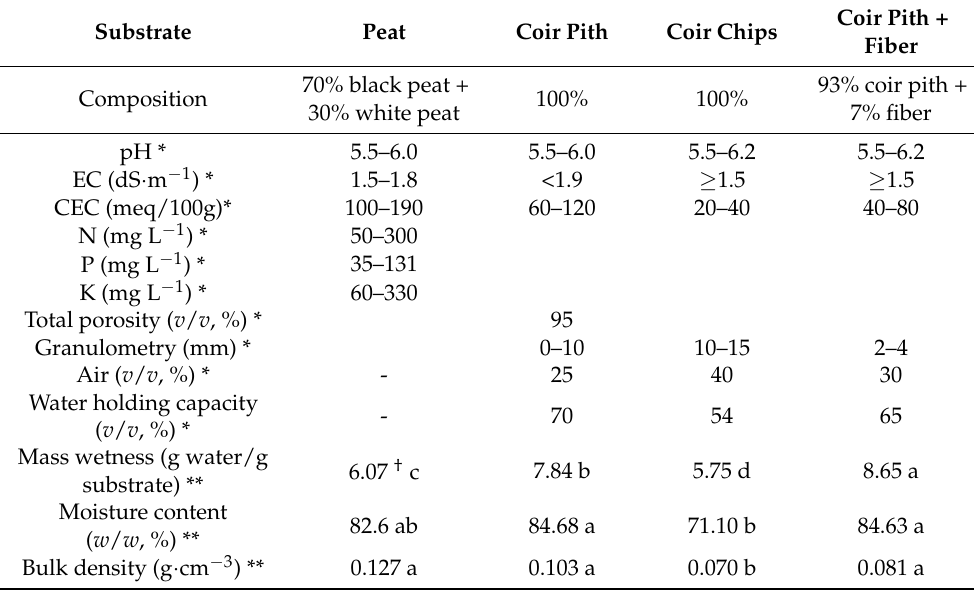
Table 1. Physicochemical properties of substrates.